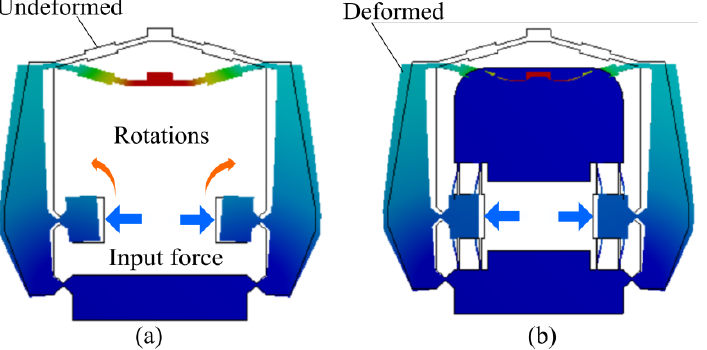
Figure 4. Parasitic motion errors with and without guiding flexure beams simulated by ANSYS software package. ( a ) Without the guiding flexure beams. ( b ) With the guiding flexure beams. It is noticed that the finite element simulation presented here is only for illustrating the parasitic motion errors. The detailed settings for the numerical simulation can be found in Section 4.